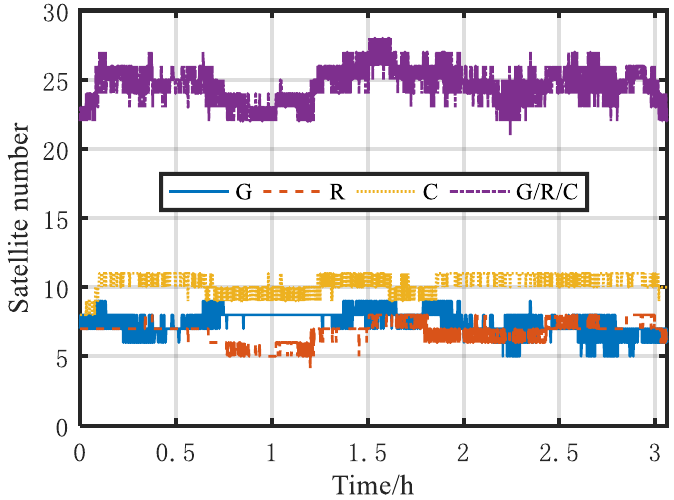
Figure 4. The number of visible satellites.